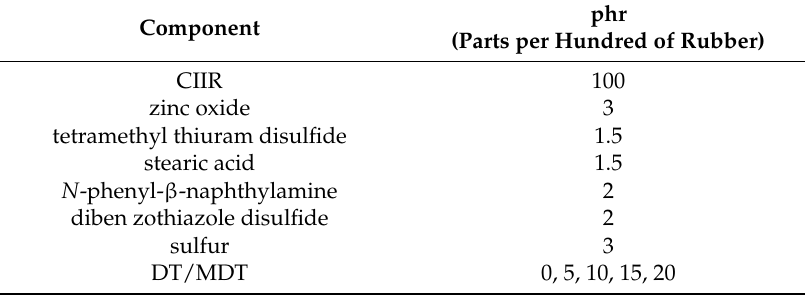
Table 1. Formulation of different CIIR composites prepared by DT and